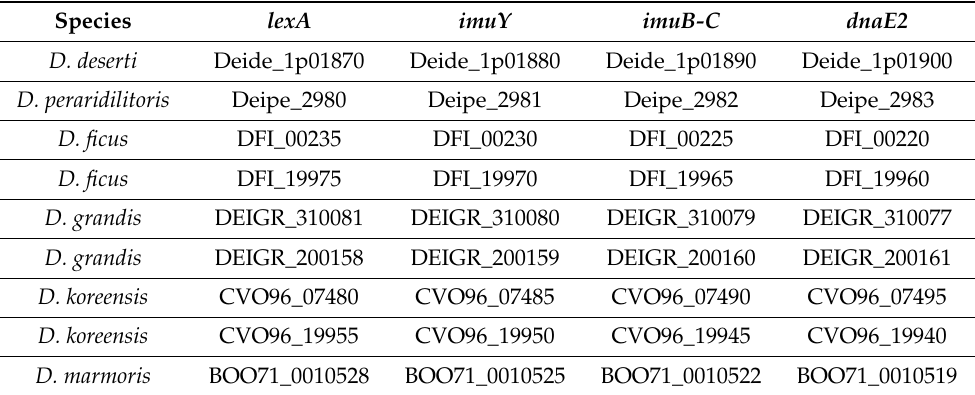
Table 1. Locus tags of the lexA-imuY-imuB-C-dnaE2 cassette of complete or published Deinococcus genome sequences. Species lexA imuY imuB-C